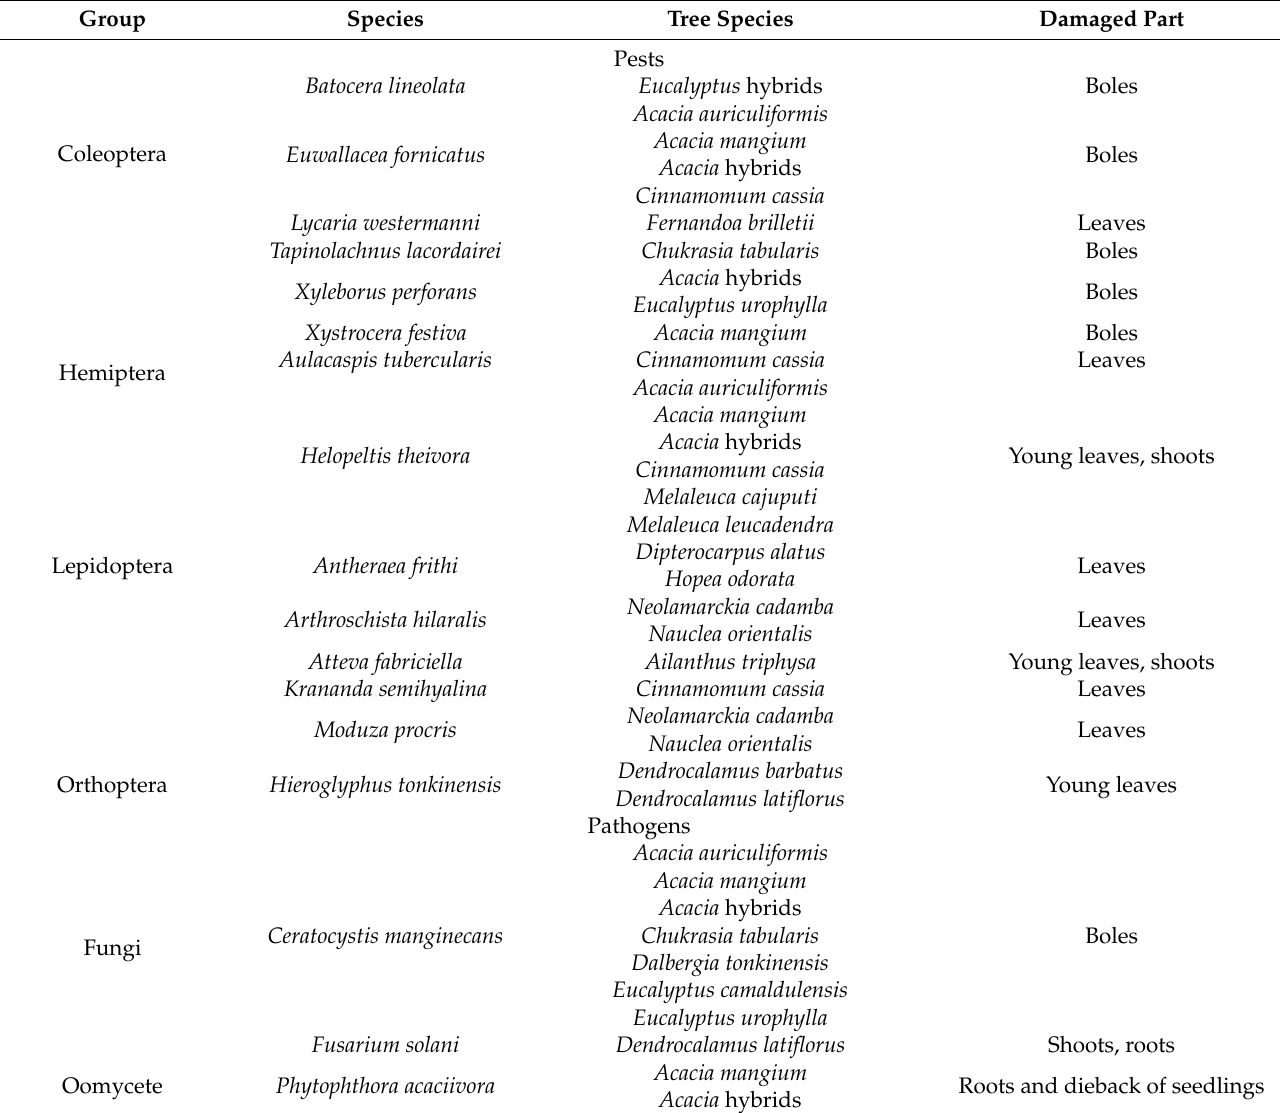
Table 2. Pests and pathogens recorded in forest health surveys in Vietnam causing significant damage to host trees.